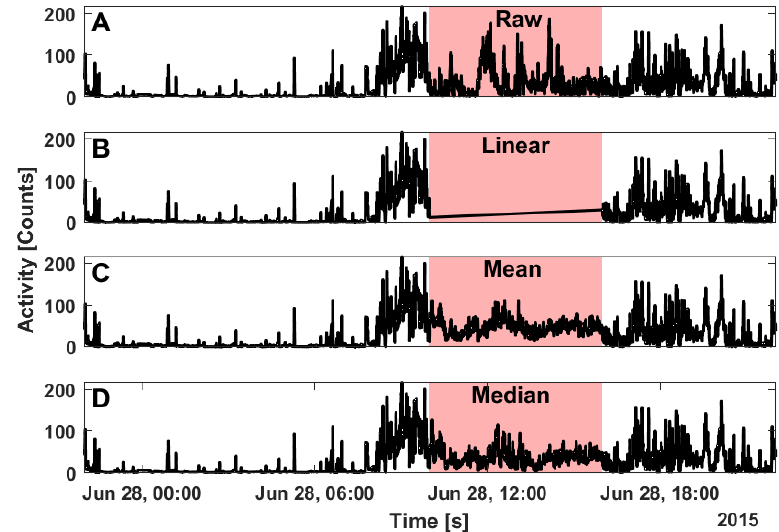
Figure 7. Example of a segment with complete data ( A ), and linear interpolation data ( B ), mean ToD imputed data ( C ), and median ToD imputed data ( D ) on 5 h of missing data starting at 10 am. Linear interpolation ( B ) is highly dependent on the values surrounding the gap, mean ToD imputation ( C ) has more smoothing than median ToD imputation ( D ); each of the imputation methods are statistical and do not perfectly represent the true data ( A ).